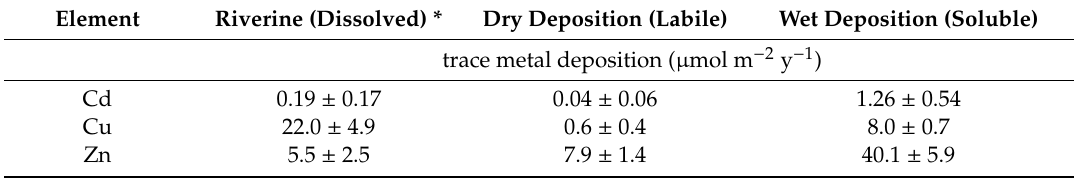
Table 2. Comparison of fluxes (in µ mol m − 2 y − 1 ) of Cd, Cu, and Zn to the GBR from the riverine system with dry and wet atmospheric deposition from this study. (*) Concentrations of TMs in